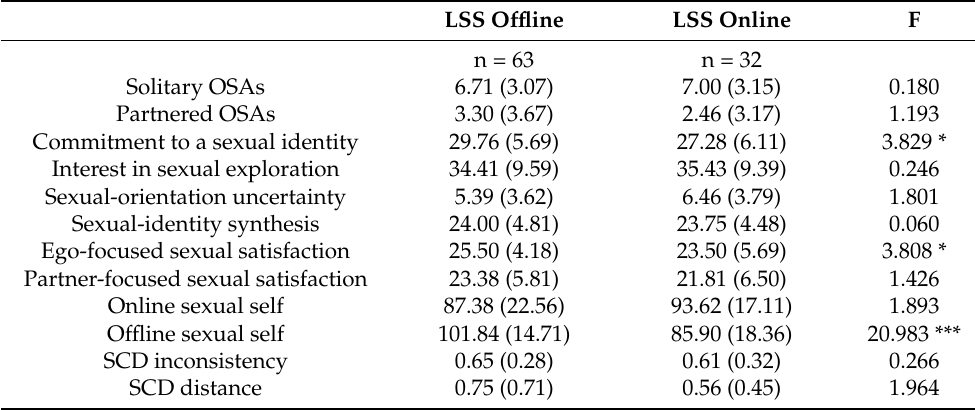
Table 2. Group comparison—ANOVA—means and standard